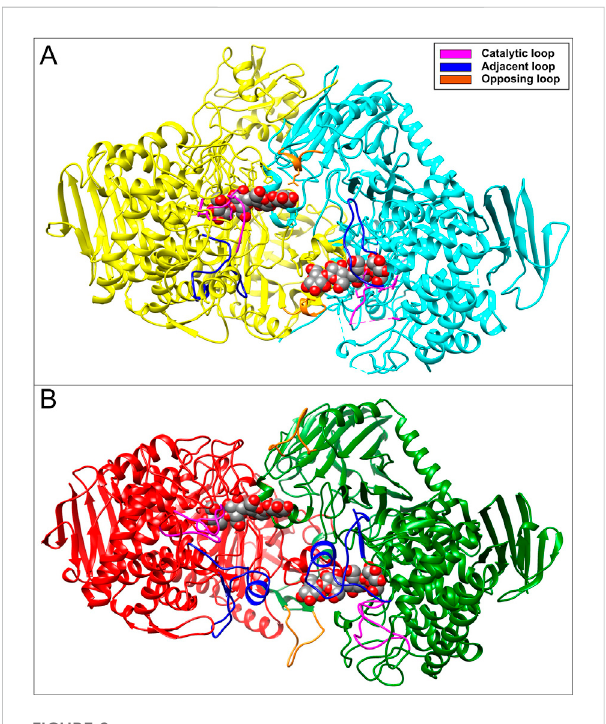
FIGURE 2 (A) Crystal structure of Ct CDP (PDB code: 5zn8) and (B) 3D- model of Ral CDP homodimer structure performed by Alphafold2. Both structures show the interaction with cellotetraose displayed as colored spheres.